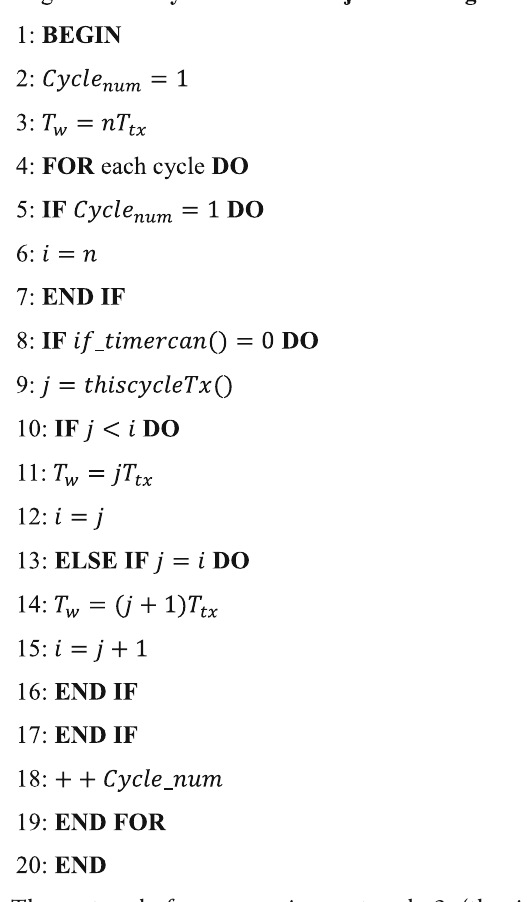
as T = 3 T . w w tx